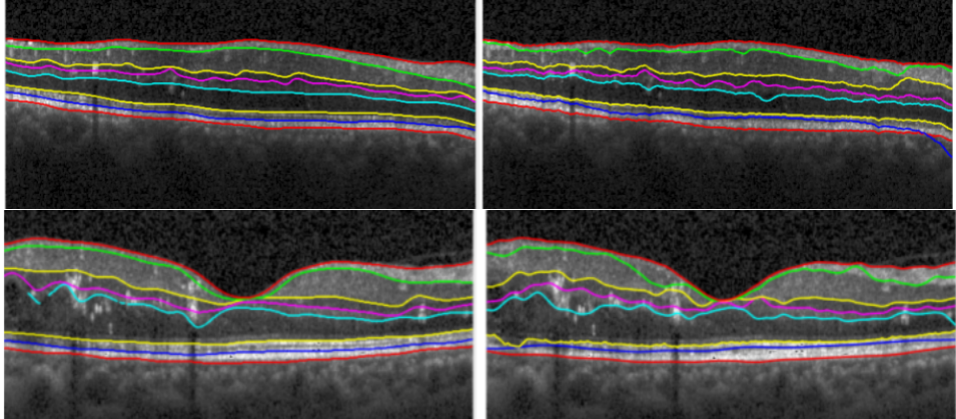
Figure 8. Comparing the results of manual segmentation ( left ) to automatic segmentation ( right ) on a healthy retina ( top ) and on a retina with condition ( bottom